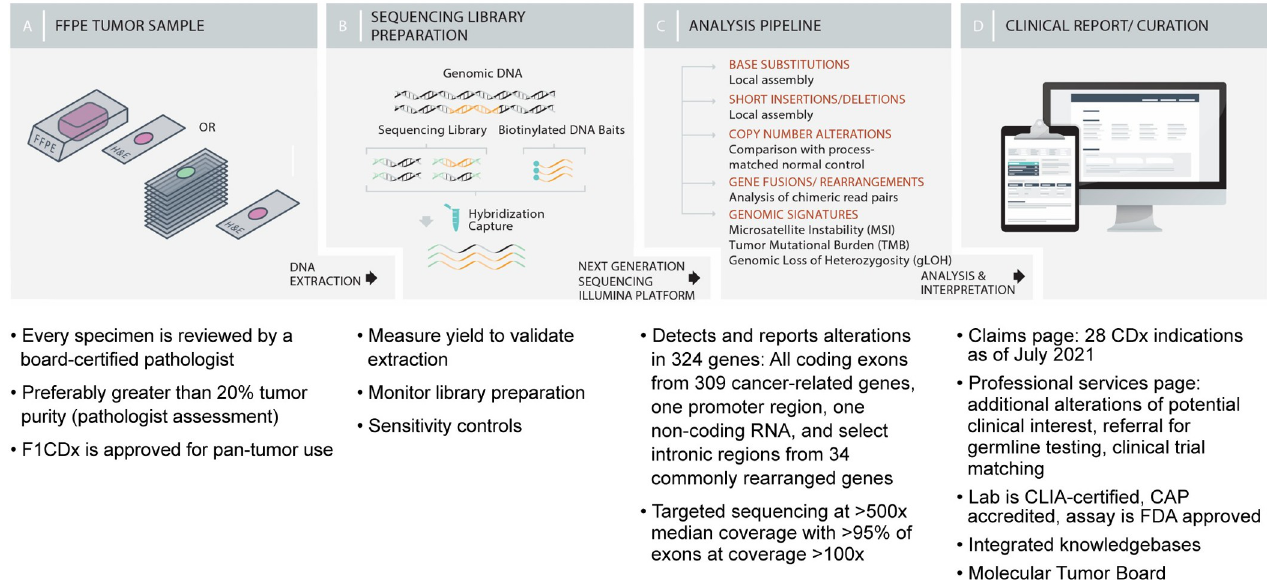
Fig 1. FoundationOne 1 CDx workflow. CAP = College of American Pathologists; CDx = companion diagnostic; CLIA = Clinical Laboratory Improvement Amendments; DNA = deoxyribonucleic acid; FDA = United States Food and Drug Administration; FFPE = formalin-fixed, paraffin-embedded.